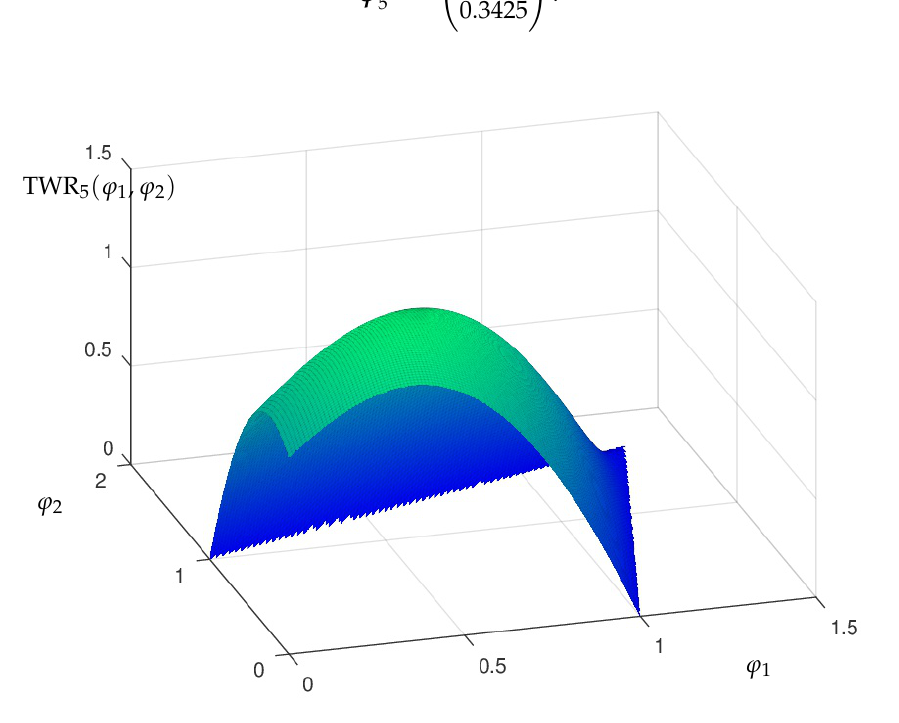
Figure 4. The Terminal Wealth Relative for T from